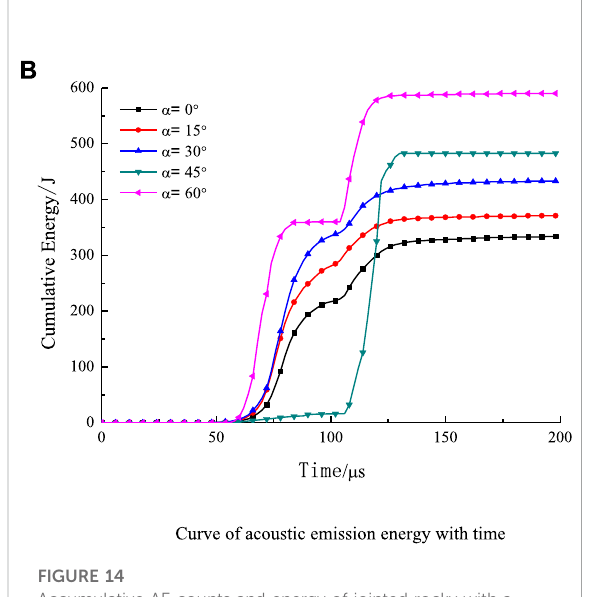
FIGURE 14 Accumulative AE counts and energy of jointed rocky with a pre-existingholeunderdifferentjointangles. (A) Variationcurveof acoustic emission number with time. (B) Curve of acoustic emission energy with time.